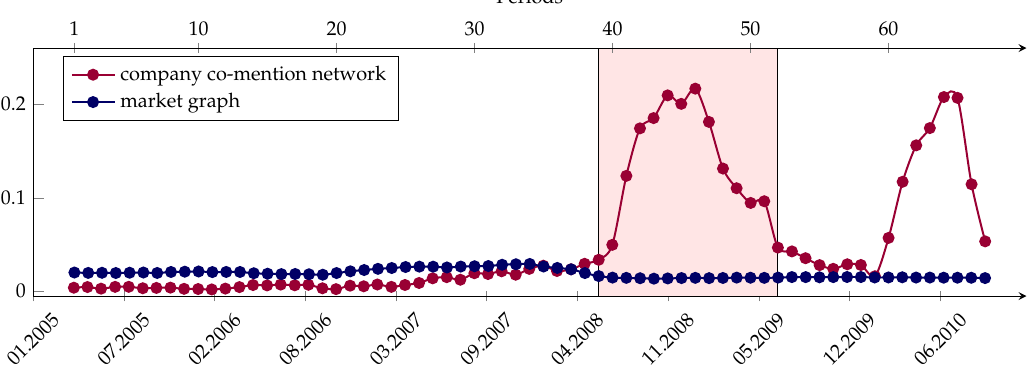
Figure 2. The dynamics of edge density for the company co-mention network (dark red) and the market graph (dark blue) from the first of 67 six-month periods (1 January 2005–30 June 2005)to the last six-month period (1 July 2010–31 December 2010). Points mark the middles of six-month periods. The outlier corresponds to 40–41